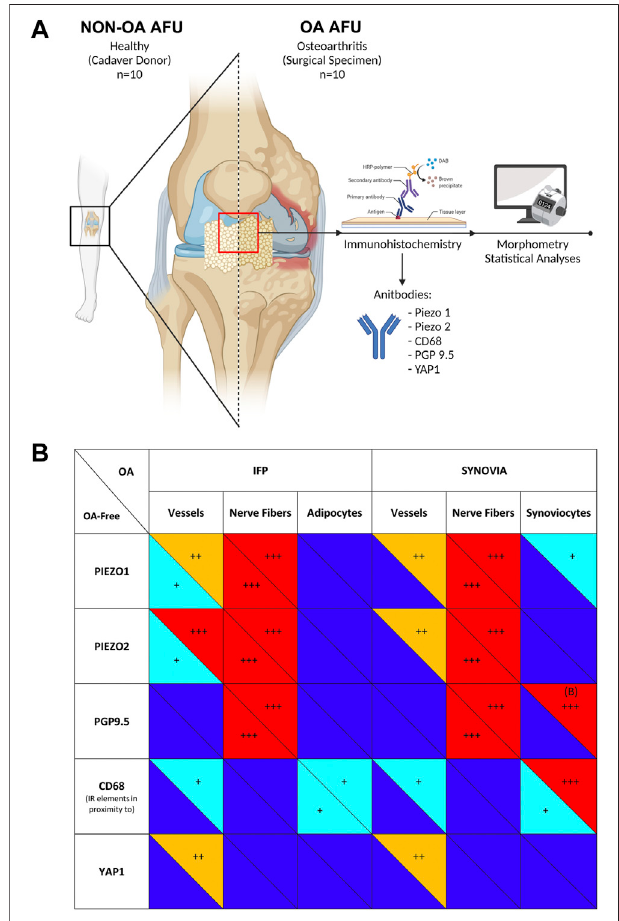
FIGURE 6 | (A) Pipeline of the study. The Anatomo Functional Units (AFUs) specimens were sampled from Donors of the Body Donation Program of the University of Padova (non-OA-AFU, n = 10) or patients with Osteoarthritis (OA AFU) during surgical procedures at the Orthopedics and Orthopedic Oncology, University-Hospital of Padova ( n = 10).Specimens were routinely processed and underwent immunoperoxidase staining. Digitally assisted morphometrical analyses were employed to quantify immunoreactivity and immunoreactive structures within the infrapatellar fat pad (IFP) and synovial membrane (SM) compartments. (B) Immunoperoxidase staining intensity for the different antibodies was graded as follows: +++ marked (red); ++ moderate (orange); + mild (light blue); no staining (dark blue). Panel A was created with